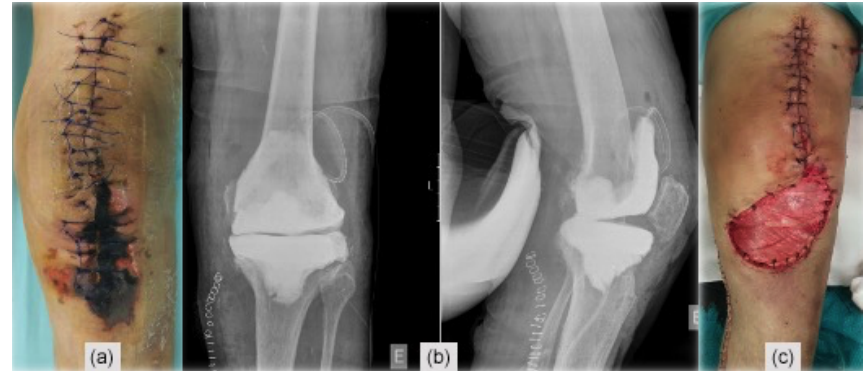
Figure 2. (a) Skin necrosis on the fifth day after DAIR, (b) X-ray after the implant removal and application of an antibiotic-loaded cement spacer, and (c) medial gastrocnemius muscle flap for wound